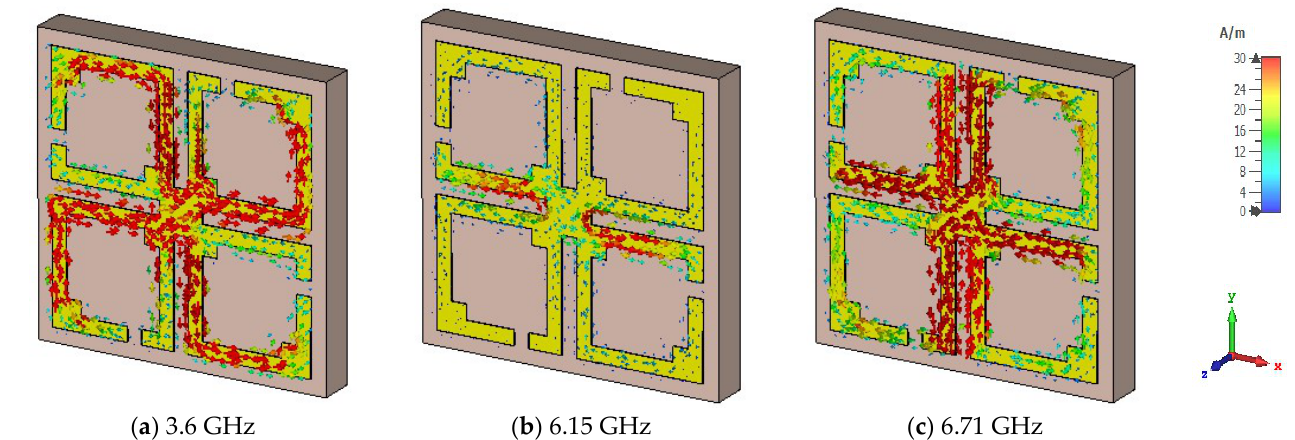
Figure 6. Distributions of the proposed MM surface current at three distinct resonances.